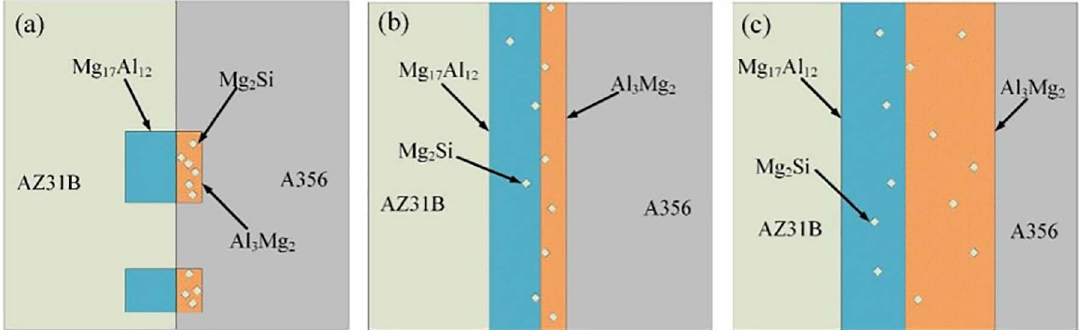
Figure 9. Schematic diagrams of diffusion process: (a) annealing temperature<250 ºC, (b) annealing temperature=250 ºC, (c) annealing temperature>250 ºC.